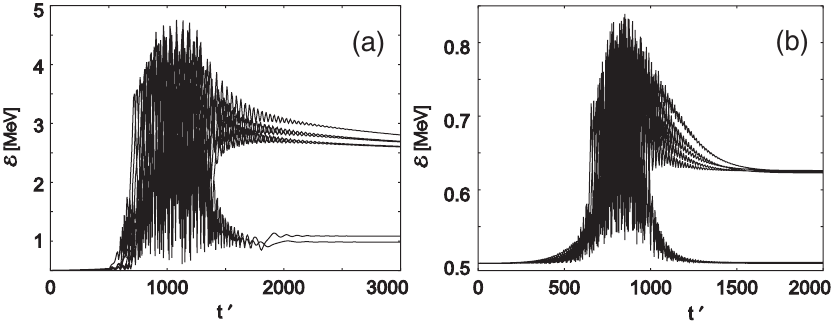
FIG. 2. The particle energy evolution in the field of two counterpropagating plane laser pulses and after the interaction corresponding to reflection-capture phenomena depended on the particle initial longitudinal positions x 0 (bunch initially in rest): (a) x 0 2 ½ 0; 30 (cid:5) 1 (cid:2) (with the step 5 (cid:5) 1 ) for ! 1 =! 2 ¼ 10 , and (b) x 0 2 ½(cid:3) 15 (cid:5) 1 ; 15 (cid:5) 1 (cid:2) (step 5 (cid:5) 1 ) for ! 1 =! 2 ¼ 2 . Other parameters are the same as noted in the text for Fig. 1.